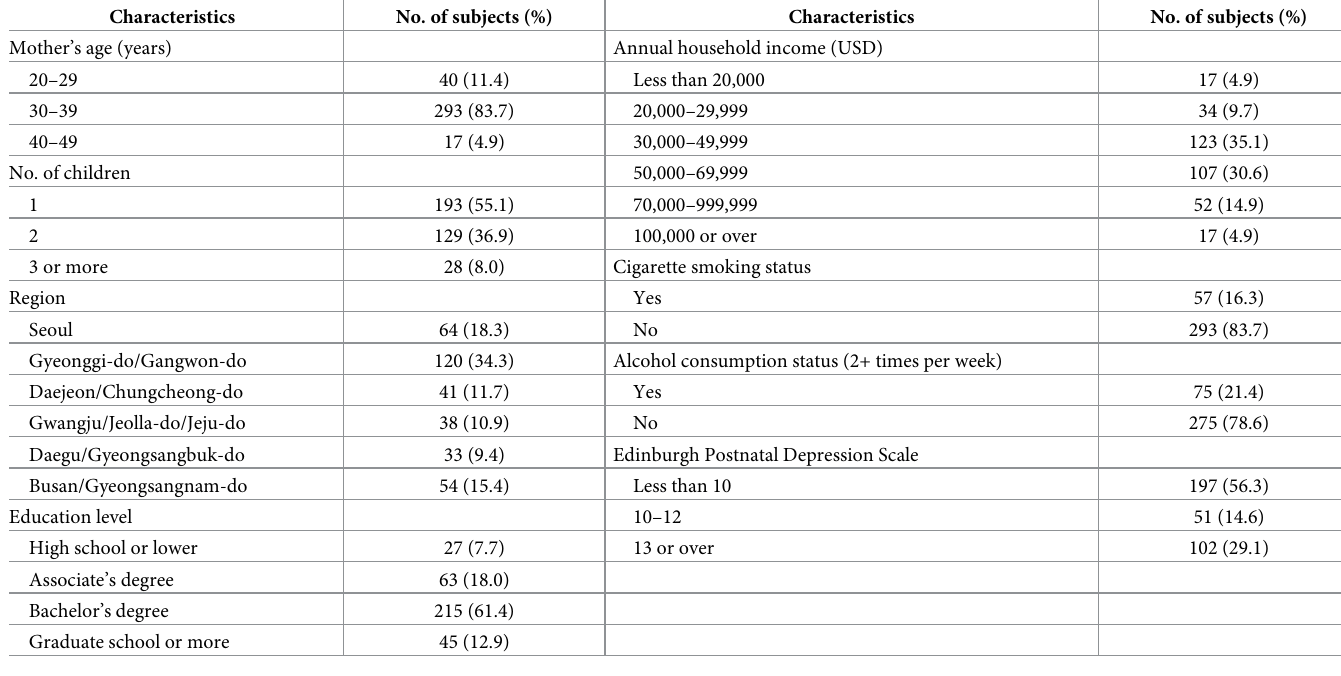
Table 1. Characteristics of the survey participants: 350 Korean women with young children. Characteristics No. of subjects (%) Characteristics No. of subjects